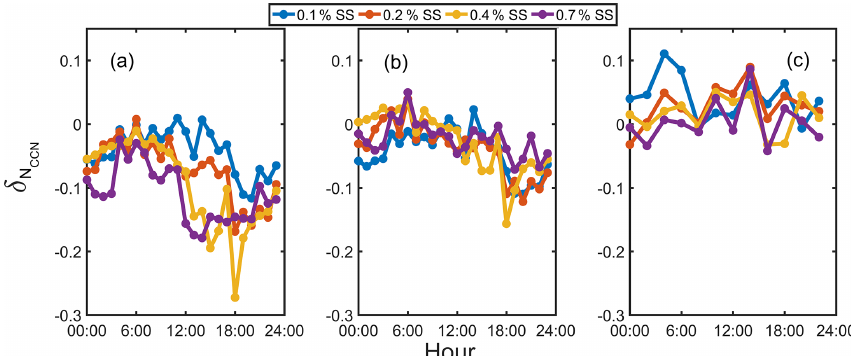
at 0.1%, 0.2%, 0.4%, and 0.7%SS based on fixed κ OA (a) , SR κ OA (b) , and SR diurnal CCN